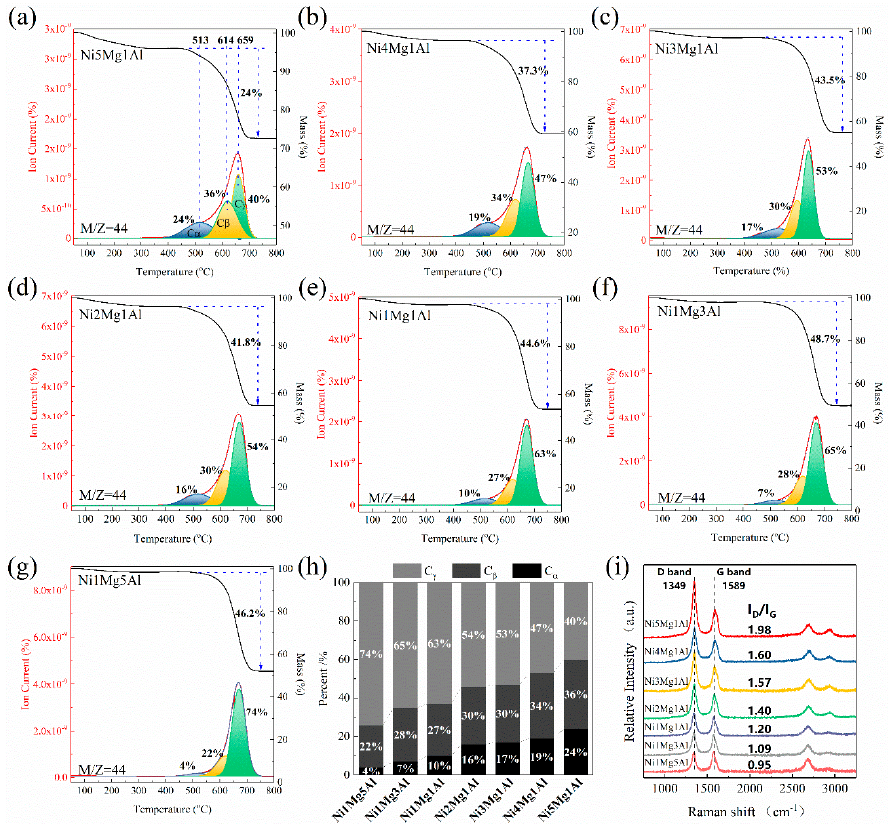
Figure 6. ( a – g ) TG-MS patterns for spent Ni x Mg y Al-800 catalysts. ( h ) Fraction of di ff erent types of carbon species for spent Ni x Mg y Al-800 catalysts. ( i ) Raman spectra for spent Ni x Mg y Al-800